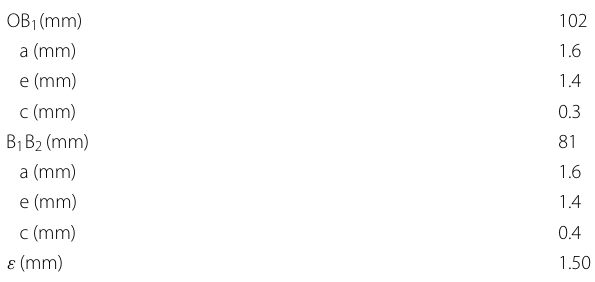
Table 4 Slit parameters and errors for the 3.5 mm inner pipe of the 5th candidate